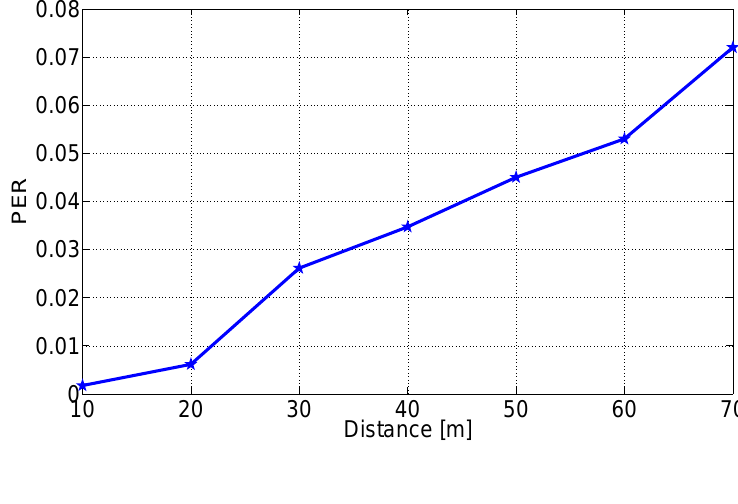
Figure 8. Experimental PER as a function of the inter-node distance, by considering P tx = 32 mW and R = 11